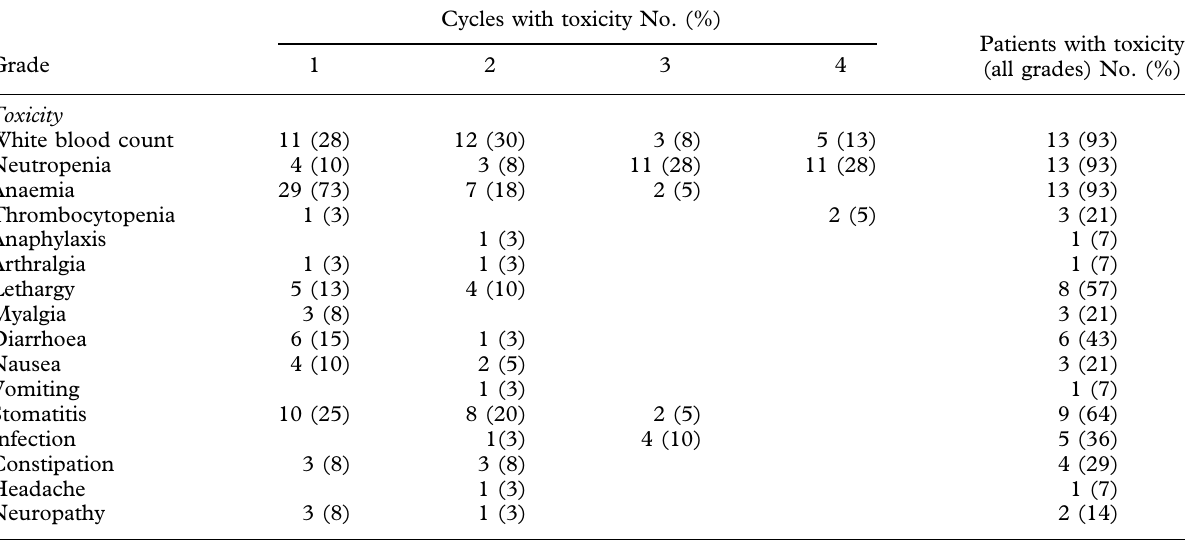
Table 2. Treatment-related toxicity Cycles with toxicity No.